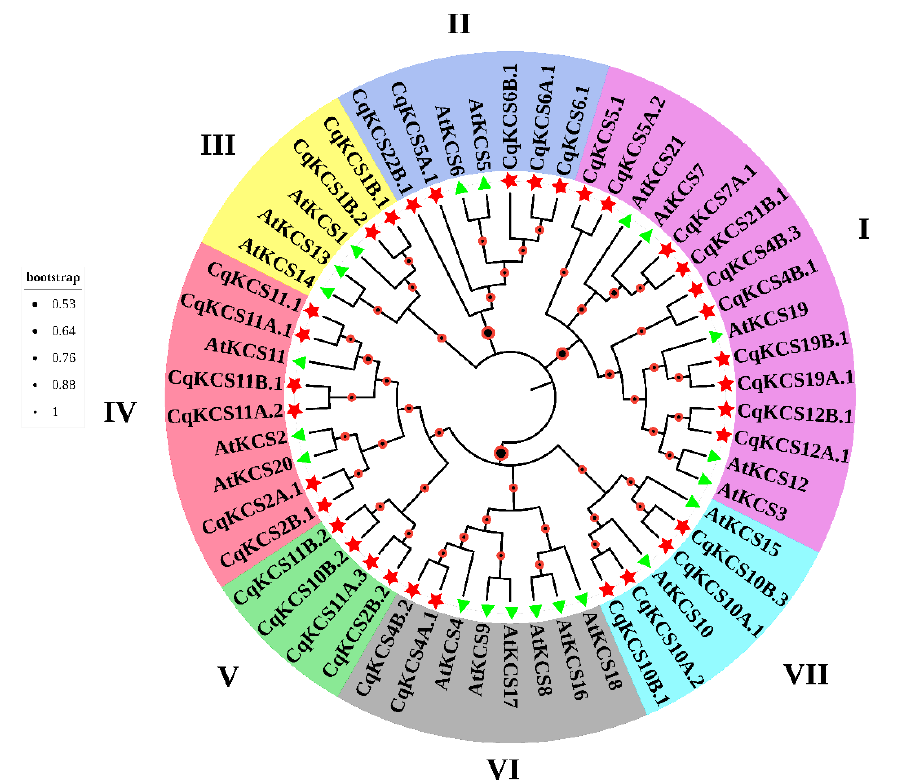
Figure 1. The evolution and diversification of the C. quinoa KCS gene family. The neighbor-joining method was used in MEGA11 to construct an unrooted phylogenetic tree of KCS (FAE1-type) using Arabidopsis and quinoa protein sequences. Bootstrap values are represented by red/black circles. Different colors in the outer ring indicate different groups.